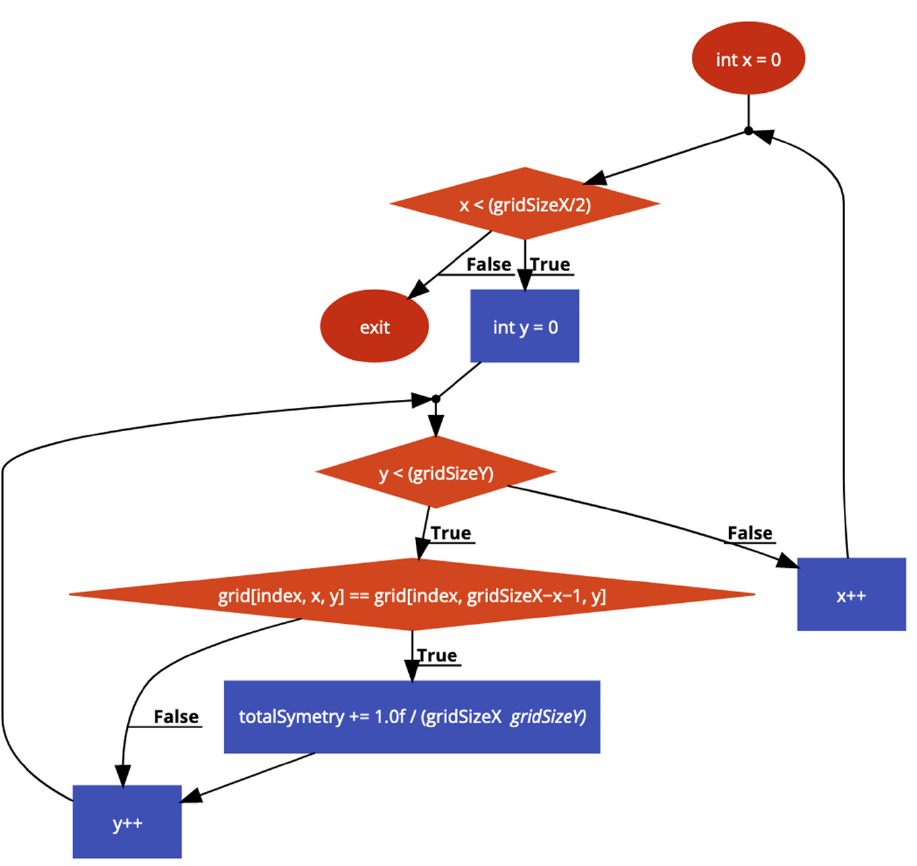
Figure 3. Symmetry calculation for single grid axis.